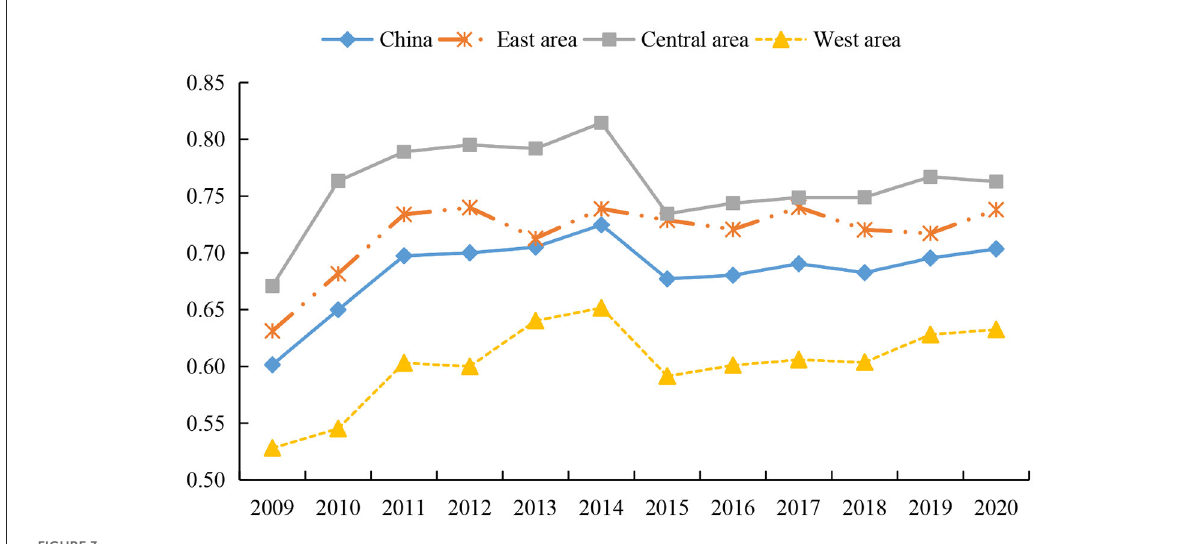
FIGURE3 Trends of resource allocation efficiency of health systems in different regions from 2009 to 2020.